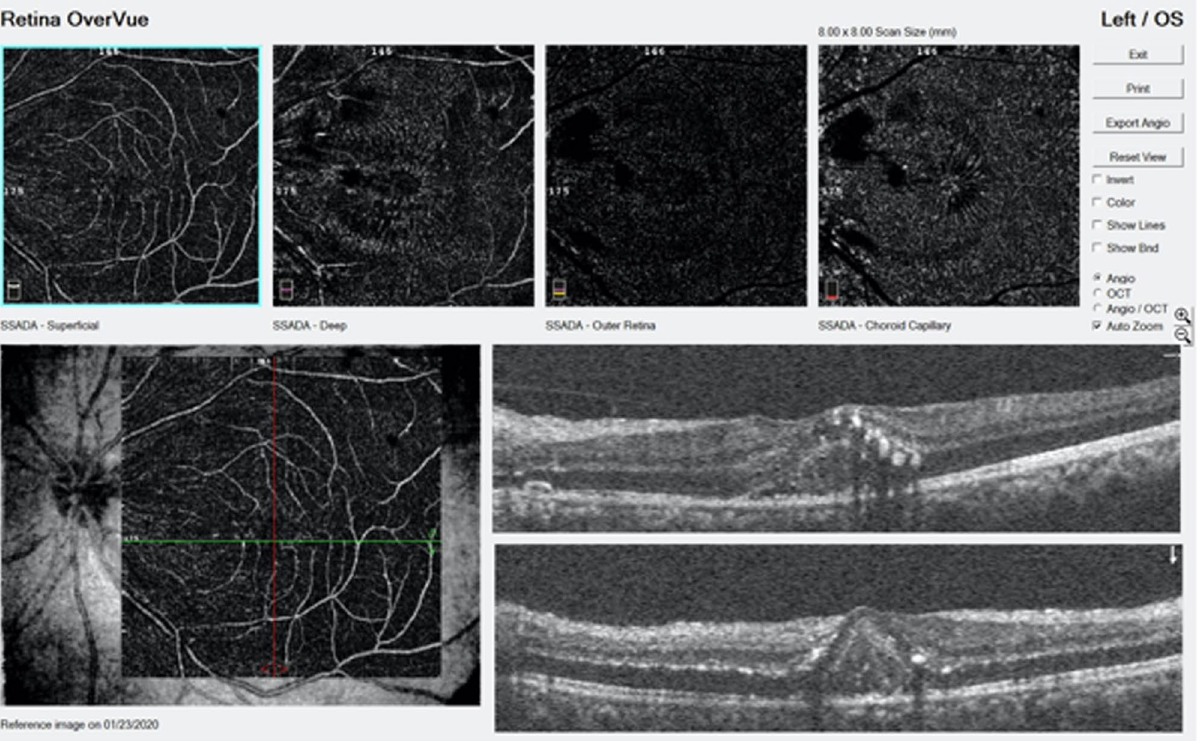
Figure 6. (Patient 24) OCTA 8 mm × 8 mm scan: Larger scan sections show the extent of retinal involvement in active retinitis. Larger vessels in SCP can be seen. Finer vasculature in SCP and DCP are poorly appreciated due to lesser resolution in larger scans. The macular involvement can be estimated from DCP onwards. A CC section shows the radial striations with brighter signals corresponding to the intraretinal HRS. A corresponding OCT B scan shows the severity and retinal involvement. OCTA Optical coherence tomography angiography, SCP Superficial capillary plexus, DCP Deep capillary plexus, OR Outer retina, CC Choriocapillaries, OCT Optical coherence tomography, FAZ Foveal avascular zone, HRS Hyperreflective